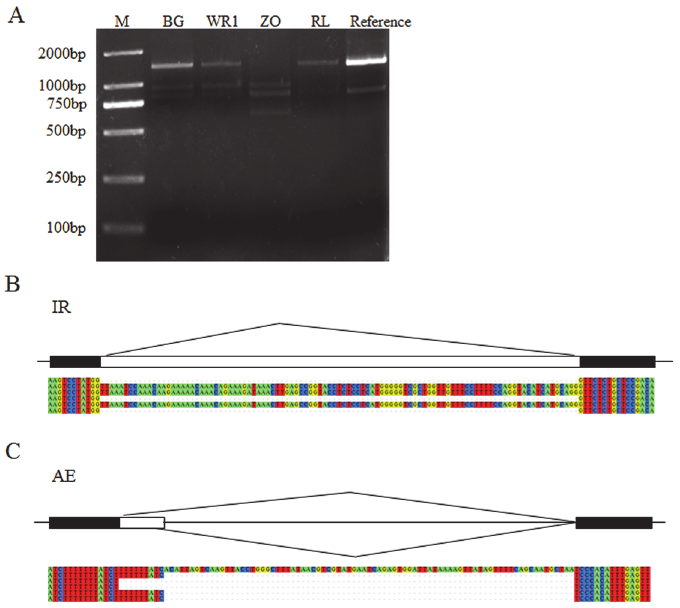
Fig 7. Validation of AS events in the Asian lotus transcriptome. (A) Validation of AS in NNU_25229-RA. (B) Validation of IR in NNU_21858-RA. (C) Validation of AE in NNU_17825-RA.